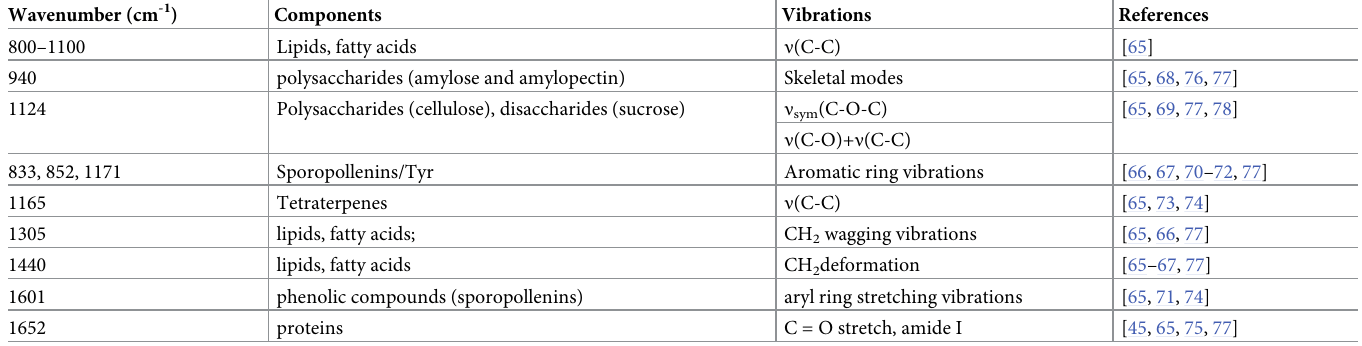
Table 2. The characterization of chemical compounds assigned to the particular bands in the FT-Raman spectra. The spectra were measured on the tablets of pollen of selected trees of Betula pendula . Wavenumber (cm -1